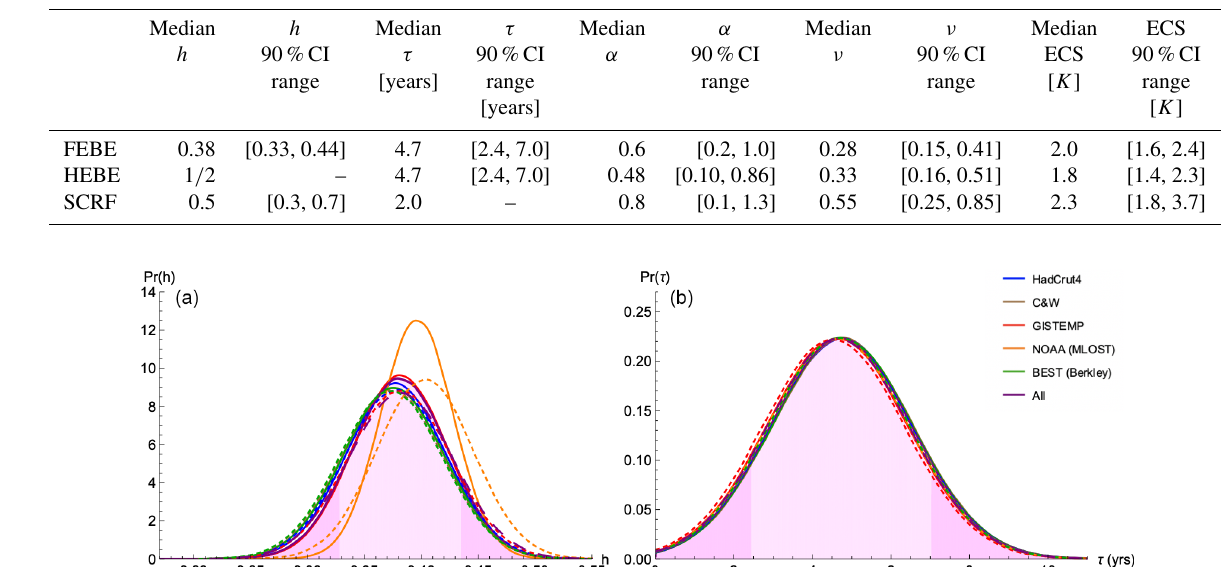
Table 3. Model and forcing parameter medians using F Aer model (Hébert et al., 2021) calibrated over the historical period, along with their corresponding 90% credible intervals.